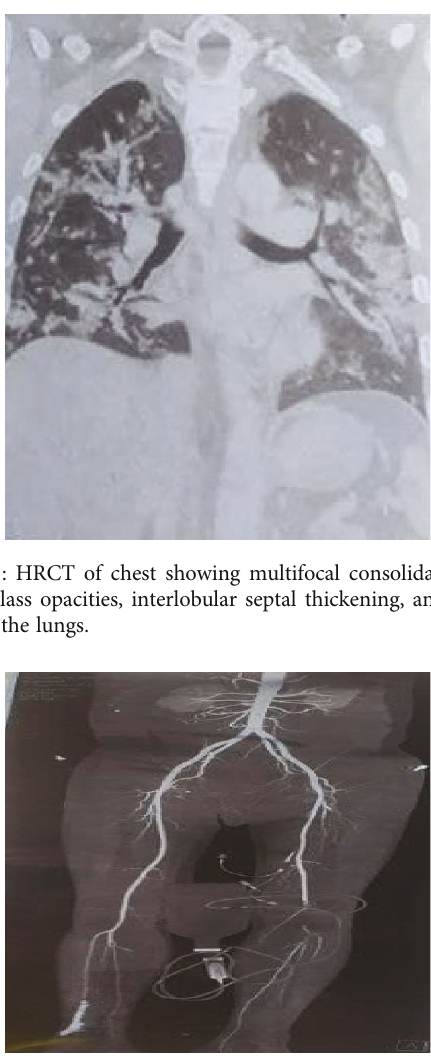
Figure 2: CT angiogram of abdominal aorta and bilateral lower limbs showing partially occluded thrombus in bilateral profunda femoris artery, completely occluding thrombus in left popliteal artery and tibioperoneal